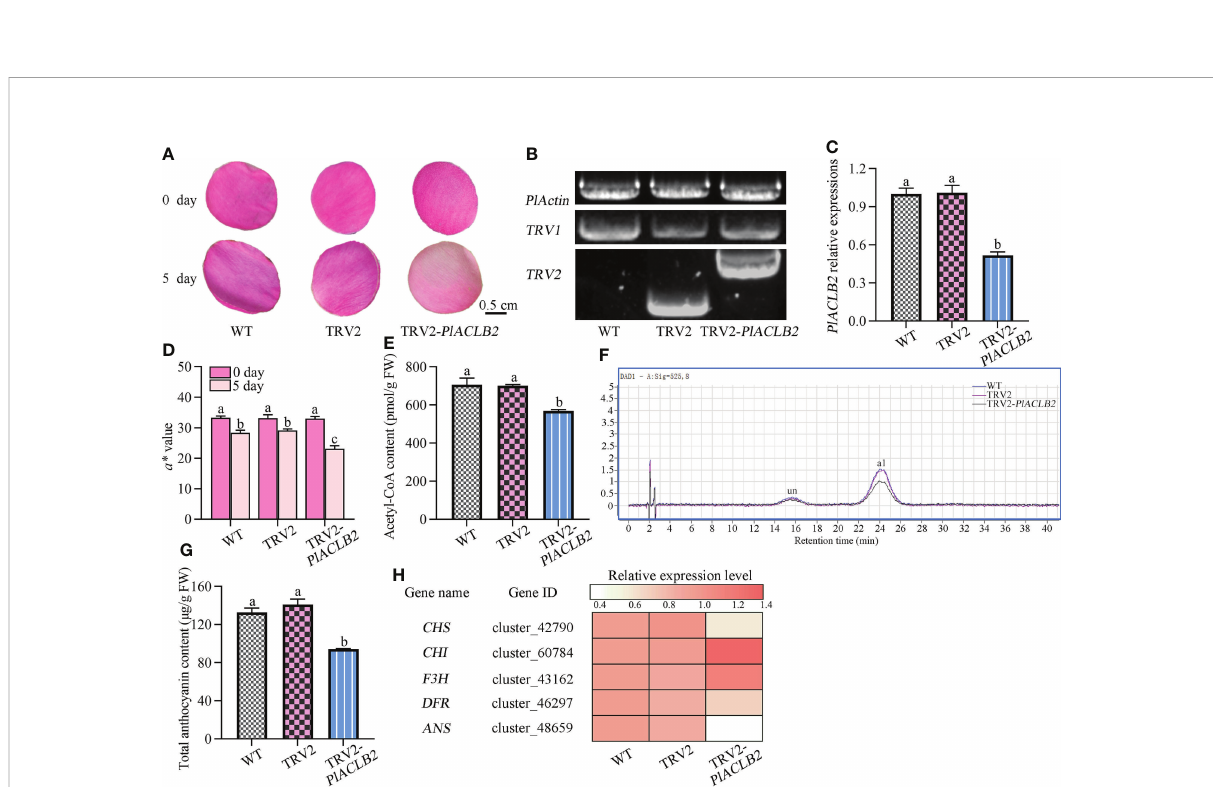
FIGURE 6 VIGS of PlACLB2 in P. lacti fl ora outer-petals. (A) Flower phenotype changes of the WT, empty vector, and PlACLB2 -silenced petals. (B) PCR validation of PlACLB2 transgenic petals. (C) qRT-PCR validation of PlACLB2 transgenic petals. (D) Measurement of red representing a* value in the WT, empty vector, and PlACLB2 transgenic petals at 0 day and 5 day. (E) Measurement of acetyl-CoA content in the WT, empty vector, and PlACLB2 transgenic petals at 5 day. (F) HPLC analysis of anthocyanin accumulation in the WT, empty vector, and PlACLB2 transgenic petals at 5 day. (G) Measurement of total anthocyanin content in the WT, empty vector, and PlACLB2 transgenic petals at 5 day. WT, wild type; un, unidenti fi ed; a1, cyanidin-3,5- O -diglucoside. (H) Heat map of expression patterns of anthocyanin biosynthesis related genes in the WT, empty vector, and PlACLB2 transgenic petals at 5 day. The values represent the means ± SDs, and different letters indicate signi fi cant differences ( P < 0.05).